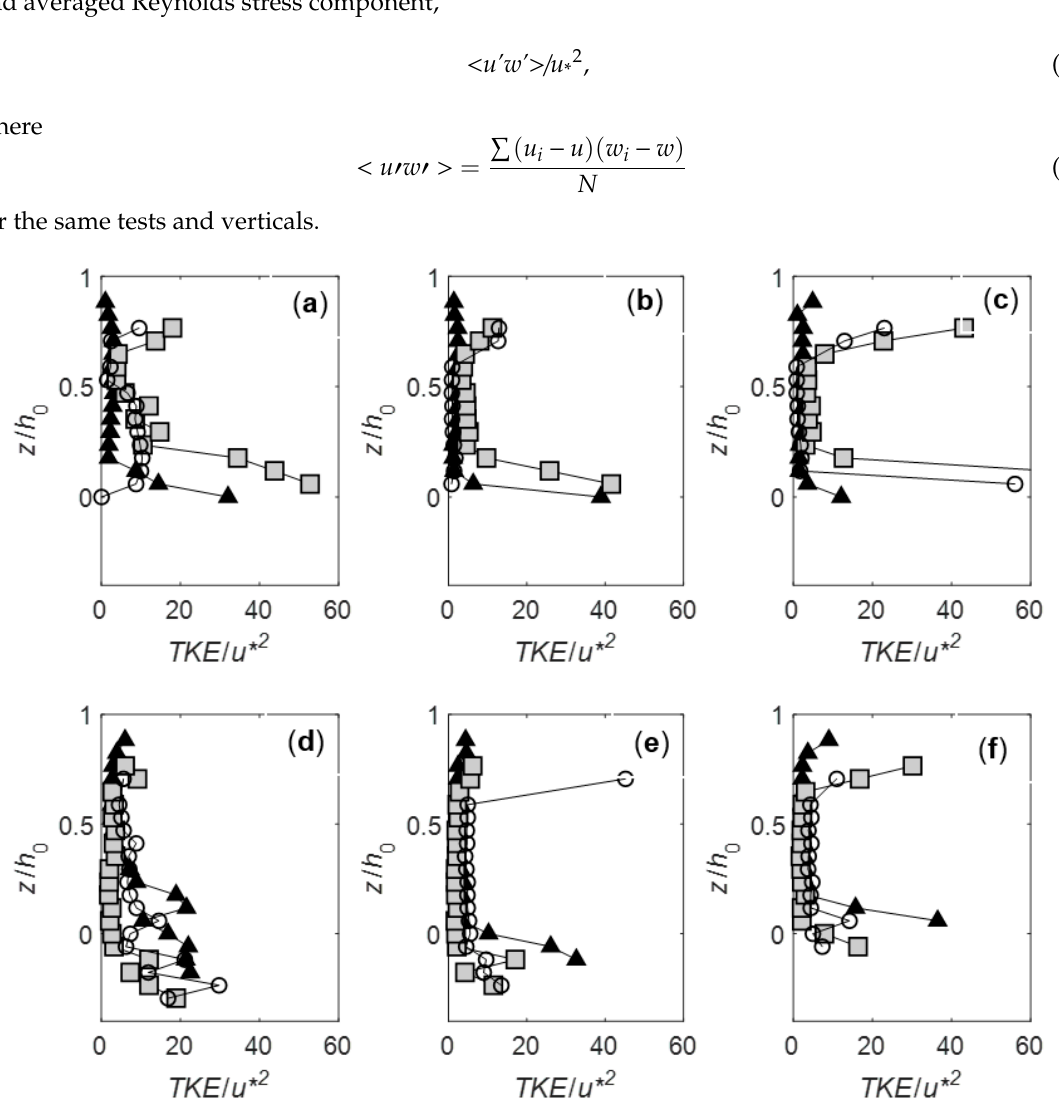
Figure 6. Comparison of total kinetic energy ( TKE) for three di ff erent verticals, ( a , d ) y / D = 0.833 , ( b – e ) y / D = 1.5, and ( c – f ) y / D = 4.2, for fixed (top rows) and mobile beds (bottom rows). Symbols are the same symbols as in Figure 2. Note that in ( c ) the values outside the plot are TKE / u * 2 = 64.4 at z / h 0 = 0.05 and TKE / u * 2 = 65.14 at z / h 0 = 0.12.